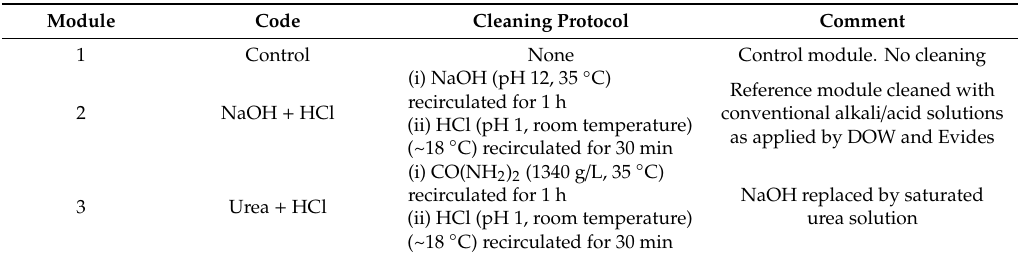
Table 1. Chemical cleaning strategies applied to each membrane element. Performance data of all three membrane modules was recorded before, during and after